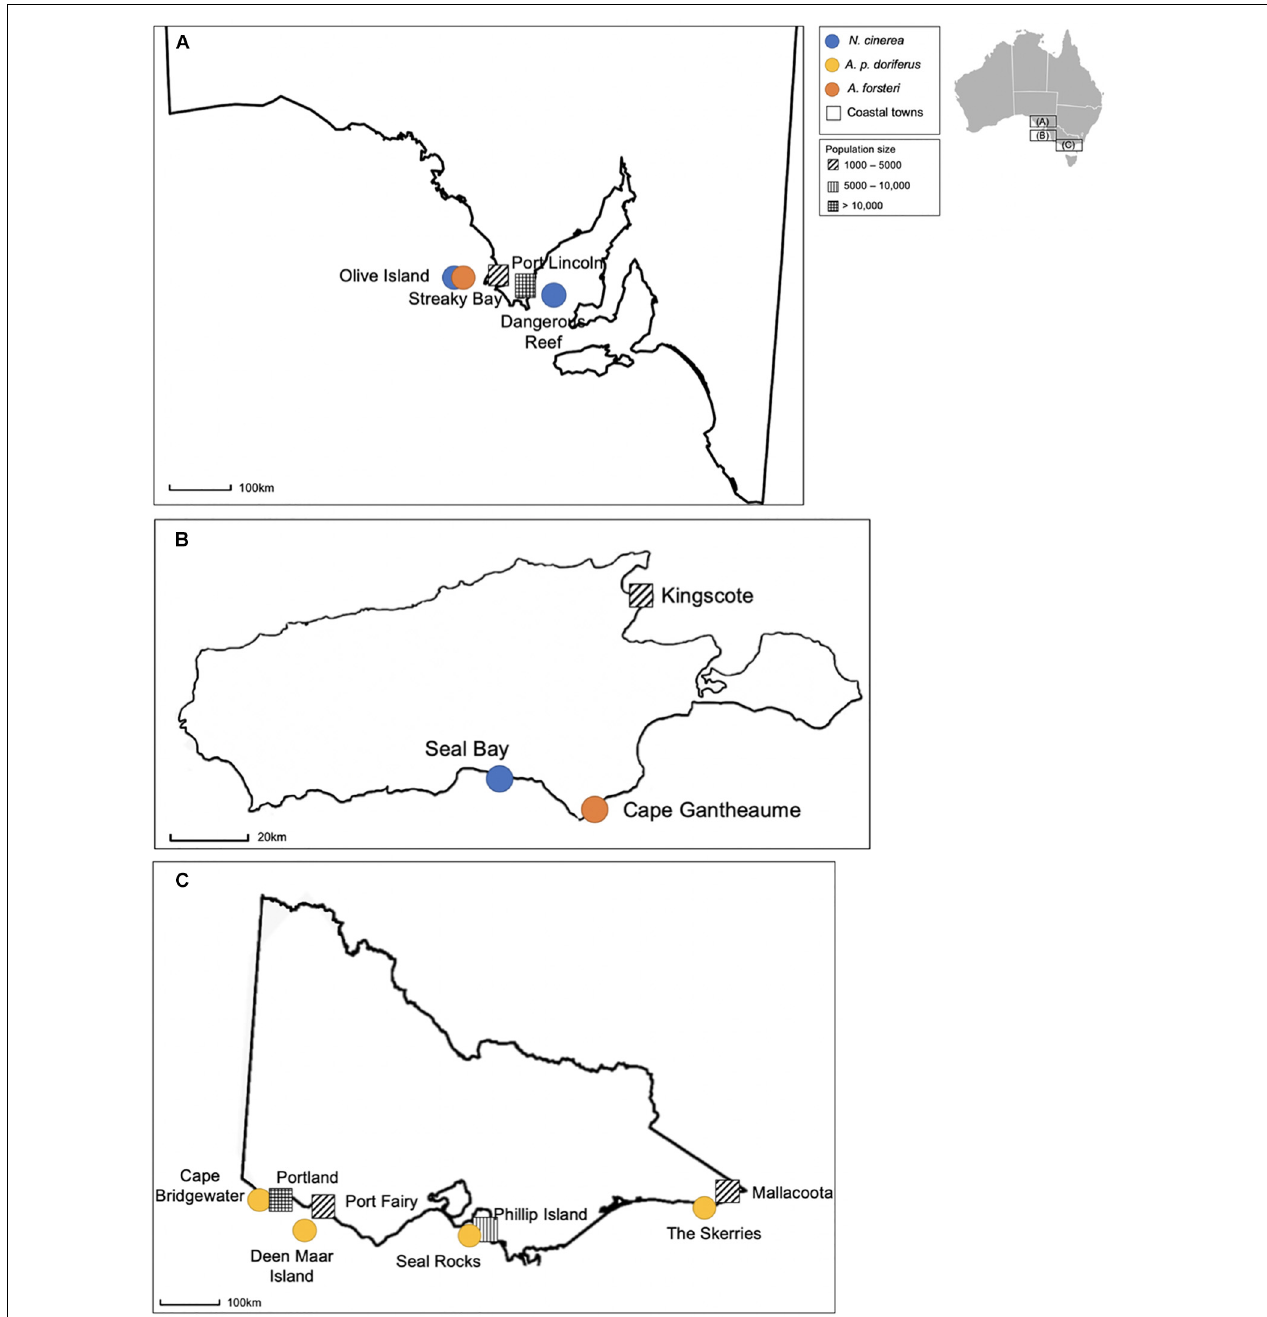
FIGURE 1 | Location of breeding colonies and species sampled at each colony in South Australia (A) , on Kangaroo Island (B) , and in Victoria (C) , with closest coastal town and approximate population size. Colonies sampled in South Australia include Olive Island, Dangerous Reef and two colonies on Kangaroo Island (Seal Bay and Cape Gantheaume). The remaining colonies, Cape Bridgewater, Deen Maar Island, Seal Rocks and the Skerries are located in Victoria.